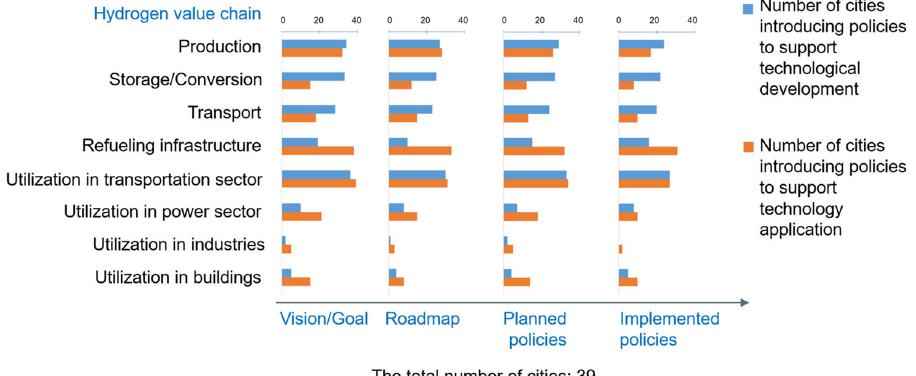
Fig. 1 City-level hydrogen technological development policies and technology application policies. Bar length represents the number of